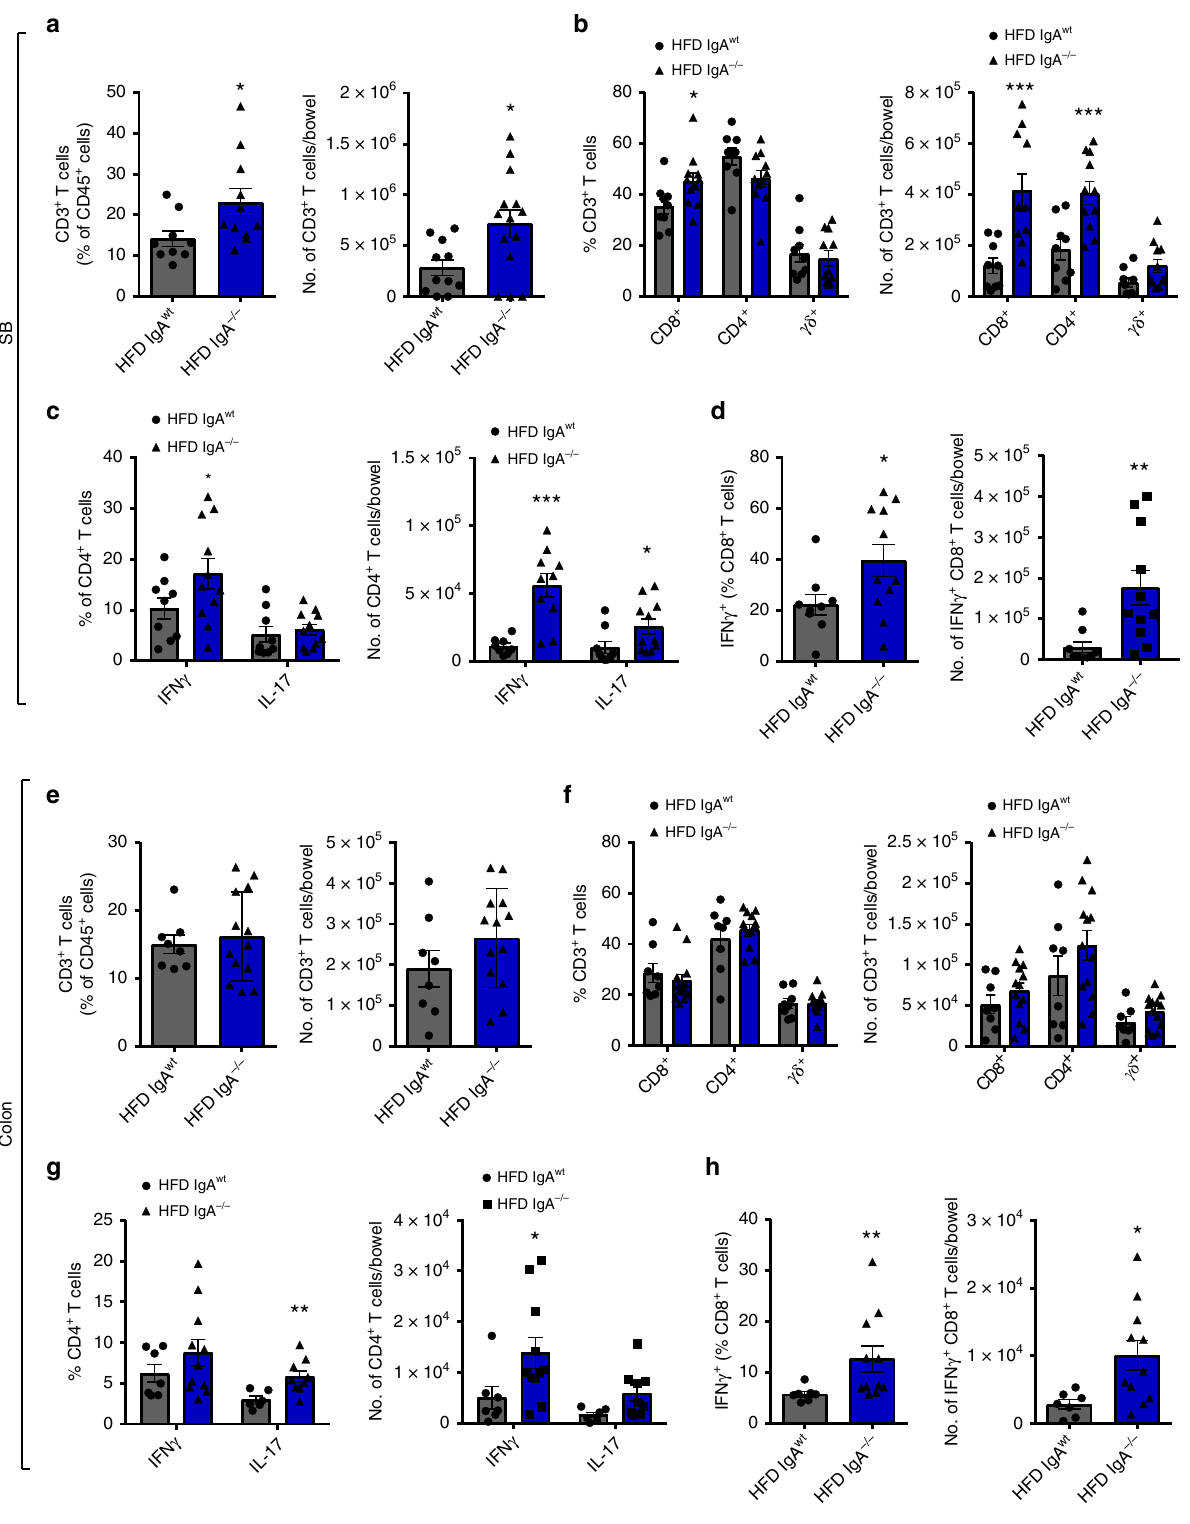
Fig. 4 Loss of immunoglobulin A (IgA) promotes pro-in fl ammatory intestinal T cell responses in high fat diet (HFD)-fed mice. Frequency (left) and absolute number (right) of a CD3 + T cells, b T cell subsets, c interferon- γ (IFN γ ) and interleukin-17 (IL-17)-producing (T-helper type 1 (Th1) and Th17, respectively) CD4 + T cells, d IFN γ -producing CD8 + T cells in the distal small intestinal lamina propria (LP) of HFD-fed IgA − / − compared to wild-type (WT) controls ( n = 9 WT, 11 IgA − / − , 4 experiments). e Frequency (left) and absolute number (right) of CD3 + T cells, f T cell subsets, g IFN γ - and IL-17-producing (Th1 and Th17, respectively) CD4 + T cells, h IFN γ -producing CD8 + T cells in colon LP of HFD-fed IgA − / − compared to WT controls ( n = 7 – 8 WT, 11 – 13 IgA − / − , 4 experiments). Data are means± SEM. * denotes p < 0.05, ** denotes p < 0.01, and *** denotes p <